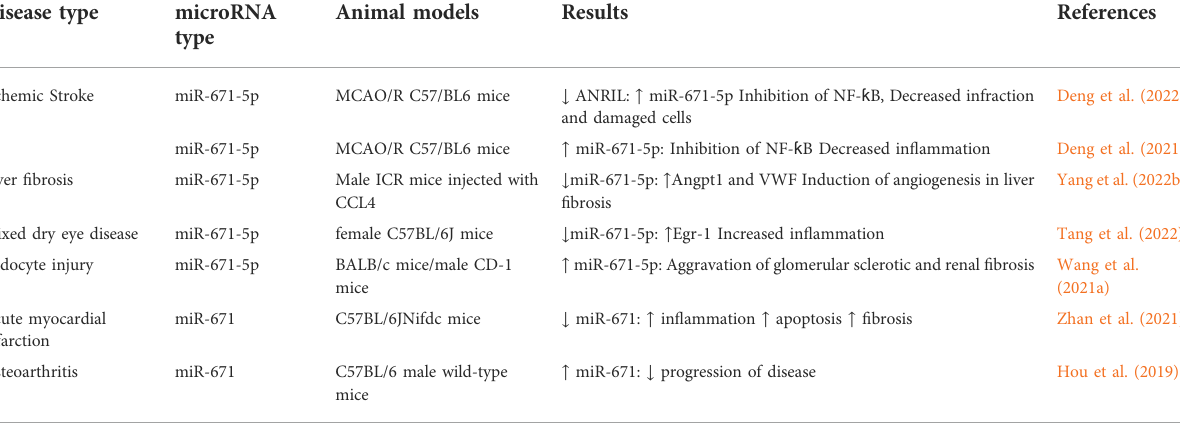
TABLE 5 Animal studies on the role of miR-671 in non-malignant conditions (MCAO: middle cerebral artery occlusion-reperfusion). Disease